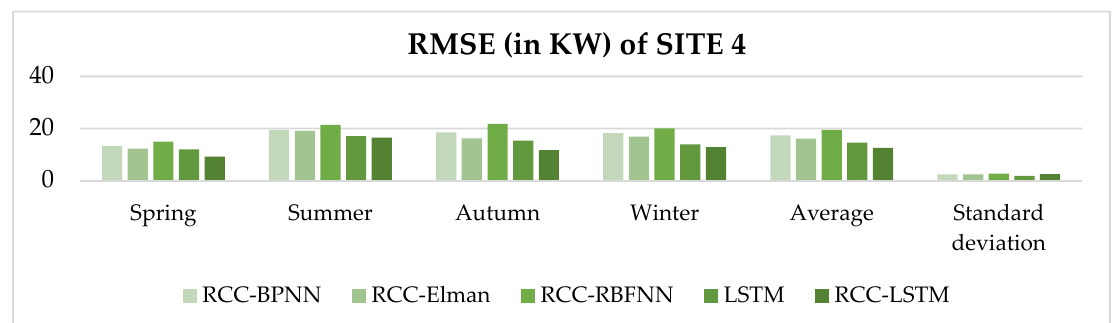
Figure 11. Comparative RMSE (in KW) results of SITE 3A.